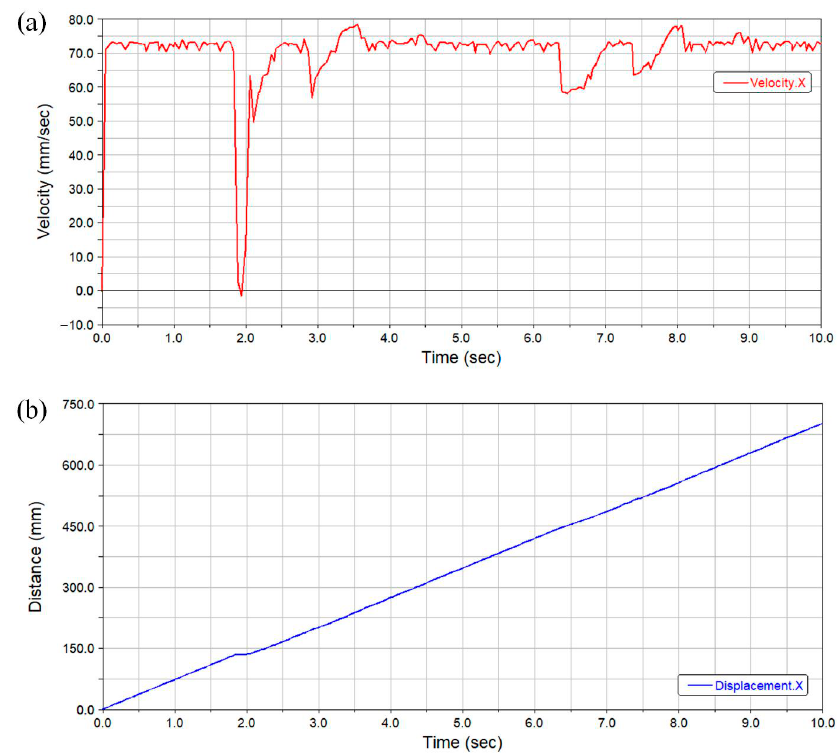
Figure 11. The simulation results of robot velocity and displacement: ( a ) Robot forward velocity; ( b ) Robot forward displacement.